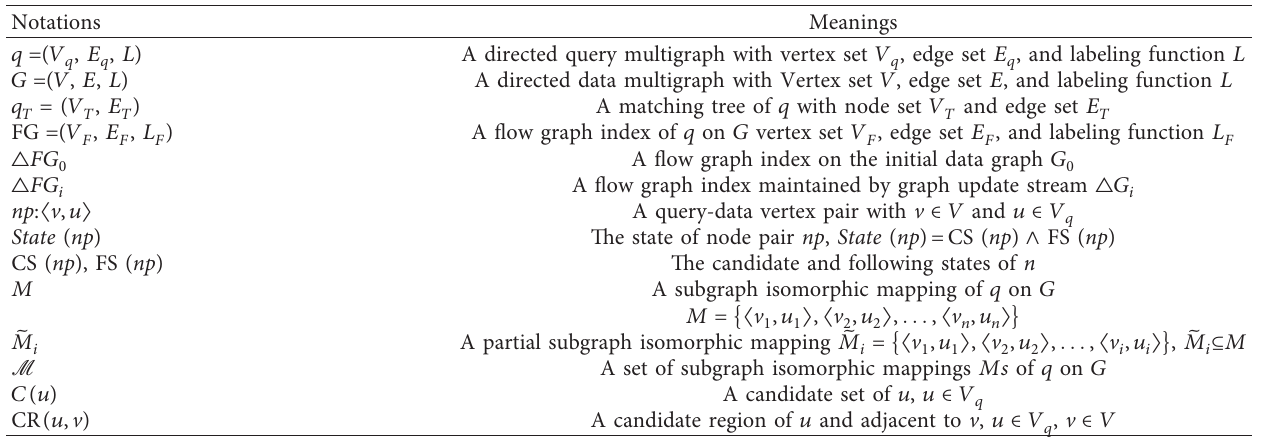
Table 1: Notations and